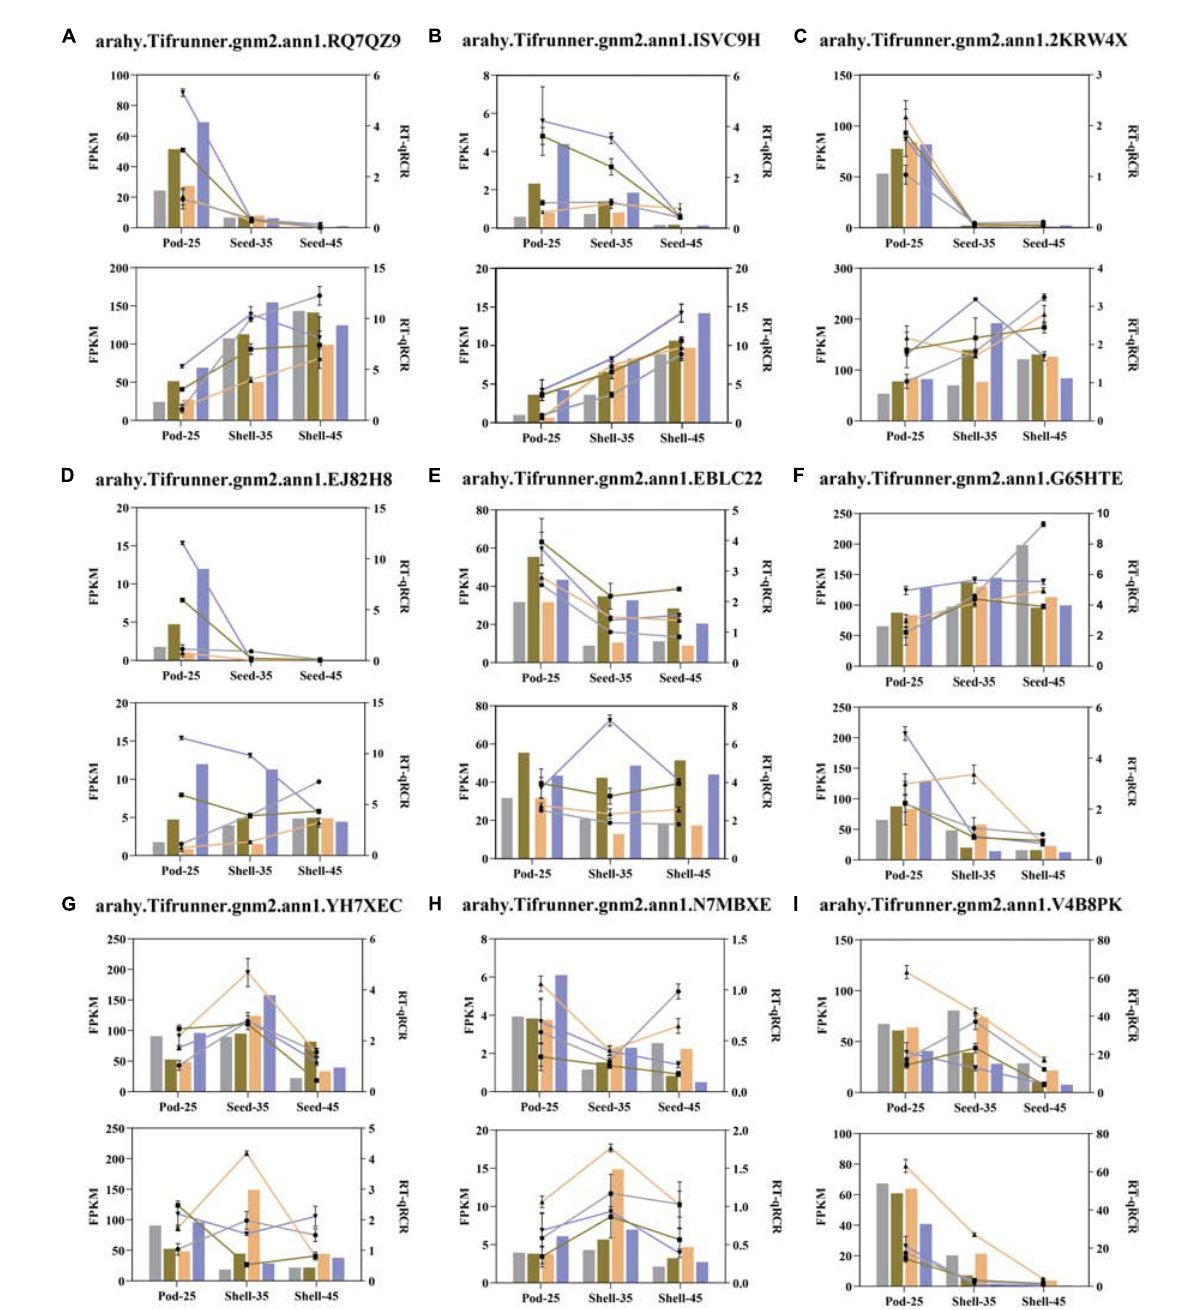
FIGURE10 Quantitative real-time reverse transcriptase polymerase chain reaction (qRT-PCR) validation of 9 DEGs related to Pod size. (A–I) The horizontal coordinate attains the developmental period and the vertical coordinate represents the gene expression level. The representative colors of YH15, W1202, S181523, and S181527 are the same as in Figure 1 . The line chart represents the relative expression determined with qRT-PCR and the column diagram represents the level of expression (FPKM) determined with RNA-seq. The relative expression levels were estimated from the threshold of the PCR cycle with the 2 − (cid:49)(cid:49) Ct method. Error bars indicate the standard errors from three independent biological and three technical replicates for qRT-PCR data.